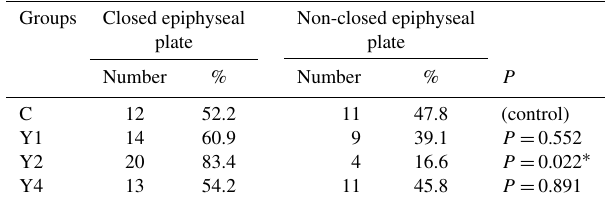
Table 5. Effects of Saccharomyces cerevisiae on epiphyseal growth plate of tibiotarsus in broiler